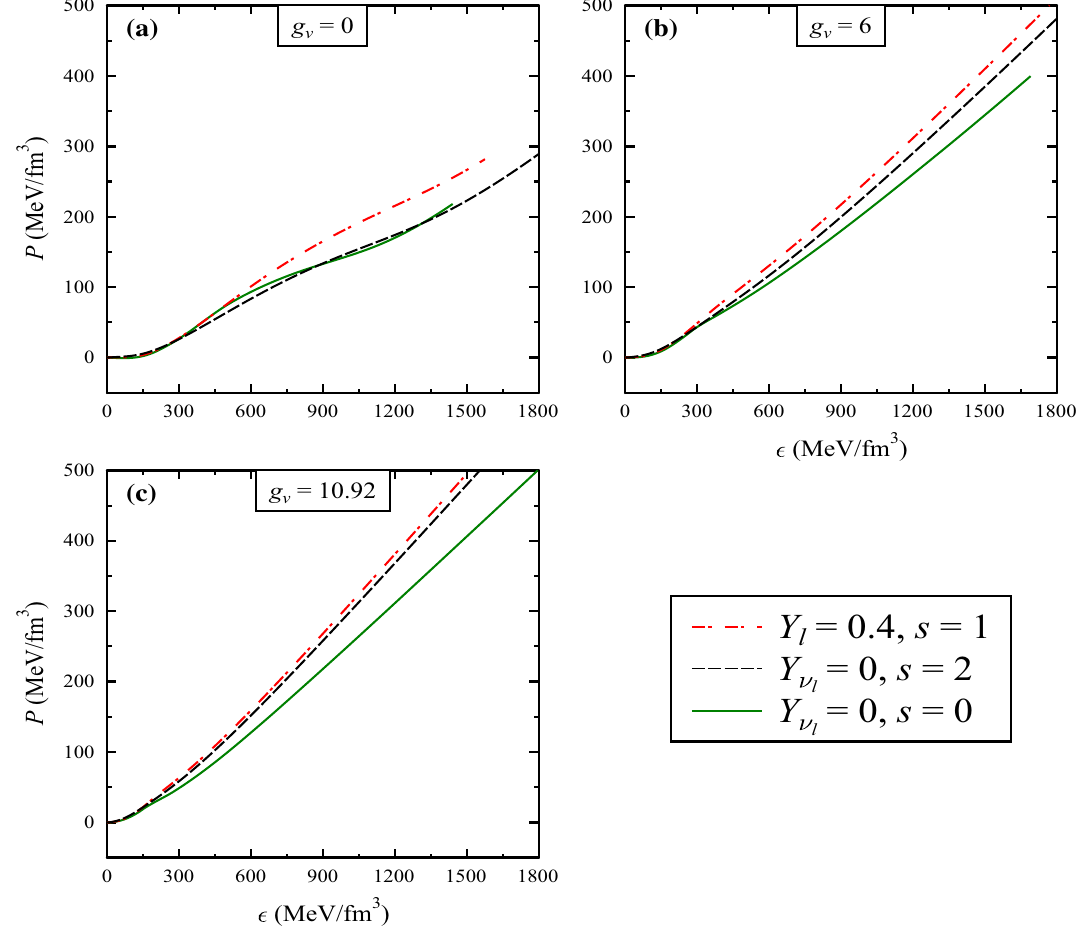
Fig. 7 The EoS plotted as a function of baryonic density ρ B (in units of nuclear saturation density ρ 0 ), for various situation of PQS evolution at g v = 0, 6 and